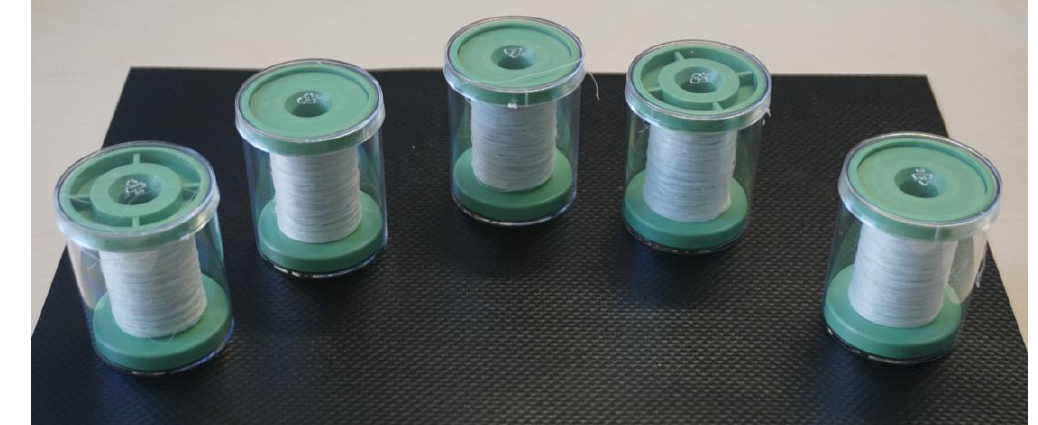
Figure 7. Schematic representation collagen wet spinning with a multifilament-core-sheath-spinneret.